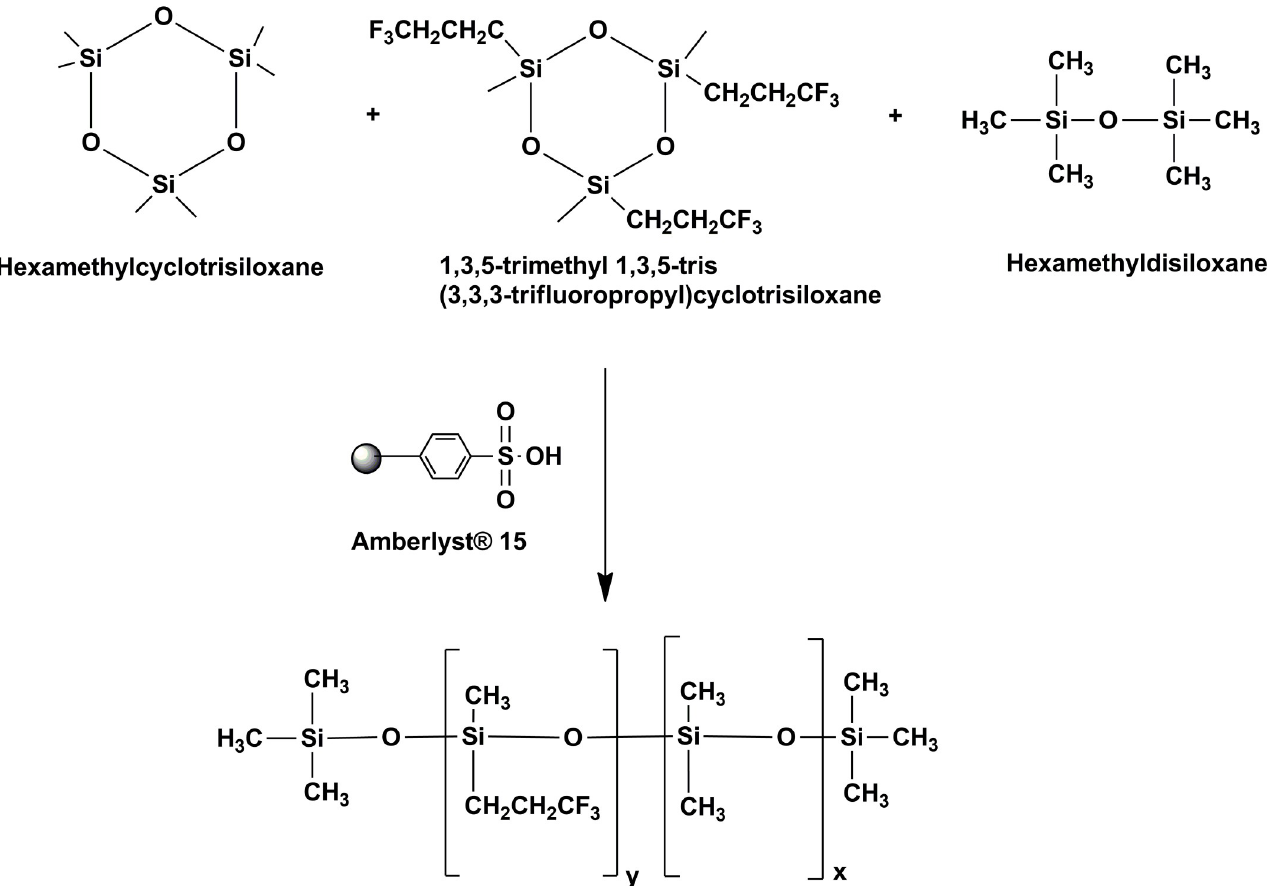
Fig 2. Ring-opening polymerization used to produce the fluorosilicone fluid. The two cyclotrisiloxane monomers (hexamethylcyclotrisiloxane and 1,3,5-trimenthyl 1,3,5-tris(3,3,3-trifluoropropyl)cyclotrisiloxane) are reacted along with hexamethyl disiloxane, which acts as a chain terminator. The catalyst Amberlyst 1 15 acts as an acid catalyst for the ring-opening